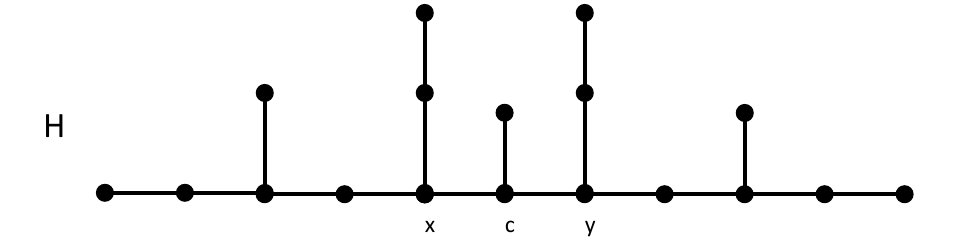
Figure 6: The tree 𝐻 in which the path-vector of the centre 𝑐 and two of its adjacent vertices 𝑥 and 𝑦 are (3 , 7 , 12 , 16 , 18 , 16 , 12 , 8 , 4 , 1). Also Examples 4.1 and 5.1 show also that two vertices in a tree with different eccentricities can have equal